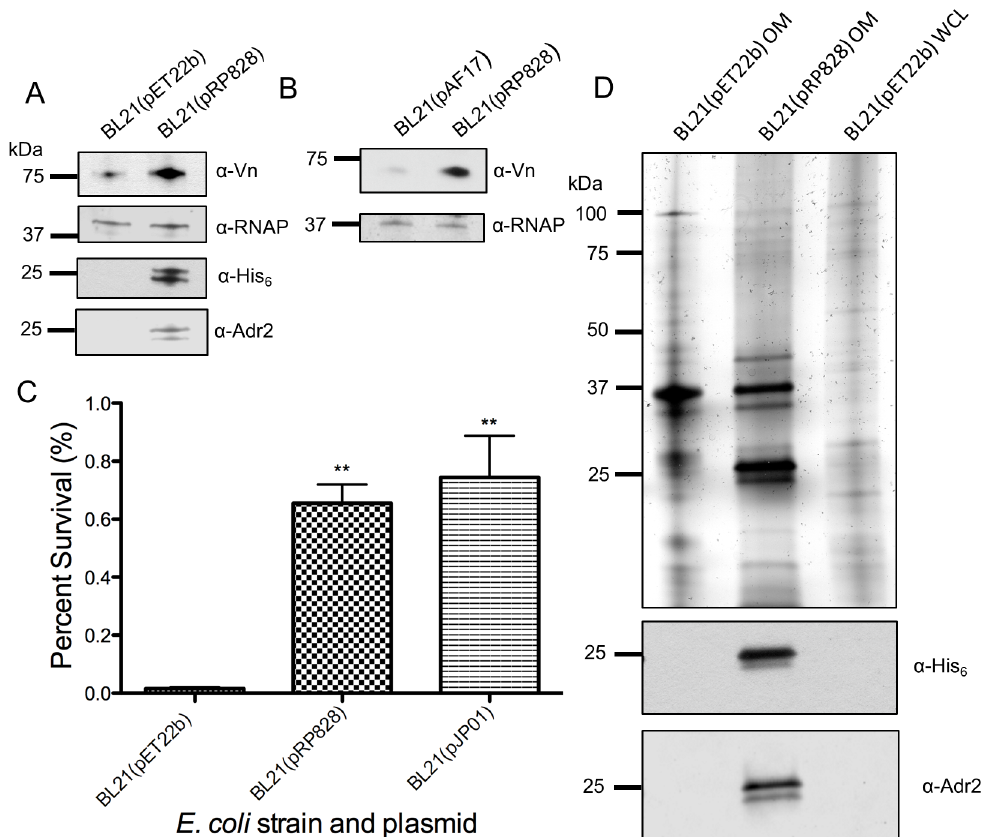
Fig 5. R . prowazekii Madrid E Adr2 confers acquisition of vitronectin and resistance in serum. (A) E . coli BL21(DE3) harboringthe empty vector pET22bor the plasmidencoding R . prowazekii Madrid E His 6 -tagged Adr2 (pRP828) were incubatedwith normalhuman serum. Western immunoblot analysisrevealed a reactive band at approximately 75 kDa in the lane with R . prowazekii Adr2 only when probedwith antibodyraised against vitronectin. Expression of Adr2 was confirmedby anti-His 6 , and equal loadingwas demonstrated with anti- E . coli RNA Polymerase alpha(RNAP). (B) Western immunoblot analysisof multimeric vitronectinbindingto E . coli expressingAdr1 derivative mutant (pAF17) or R . conorii Adr2. Expression of both the Adr1 derivative and Adr2 was confirmedby anti-His 6 , and equal loadingwas verified using anti- E . coli RNA polymerase alpha (RNAP). (C) Expression of R . prowazekii Adr2 in E . coli BL21(DE3) is sufficient to mediateresistancein the presenceof serum. Results are shown as the mean ± SD (P value: ** = 0.0024) and E . coli harboring R . conorii Adr1 (pJP01) was used as a positive control. (D) OM preparations or WCL from E . coli transformed with the empty vector (pET22b) or the plasmidencoding for R . prowazekii His 6 -tagged Adr2 are separatedby SDS-PAGE. Subsequent silver stainingdemonstrates similar protein loadingand migration. Anti-His 6 was used to demonstrate expressionof R . prowazekii Adr2. A reactive band at approximately 25 kDa was observed when probedwith anti- R . conorii Adr2.